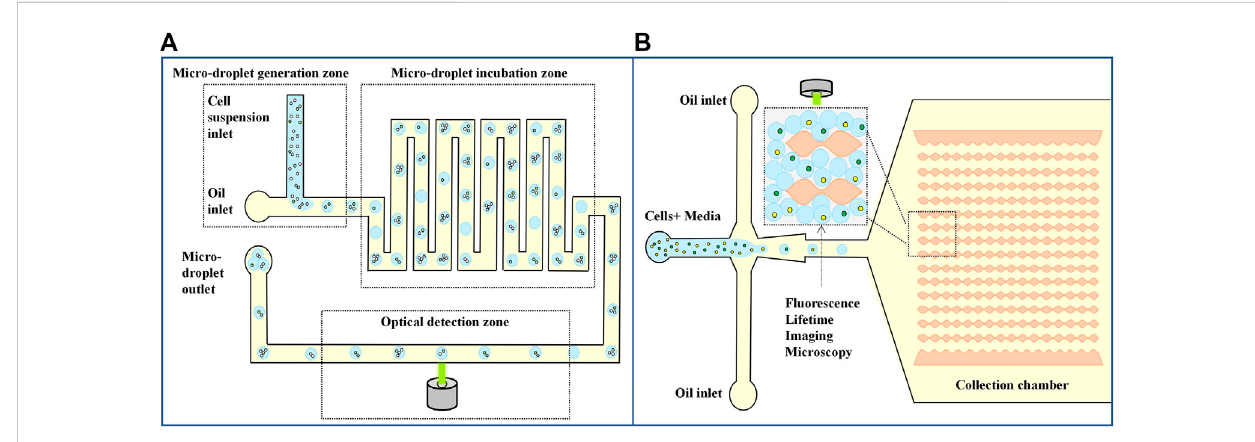
FIGURE 6 Droplet micro fl uidics for Single cell detection. (A) Schematic diagram of a micro fl uid based optical sensing device for labeling free detection of circulating tumor cells (Chiu et al., 2015). (B) Label-free metabolic classi fi cation of single cells in droplets using the phasor approach to fl uorescence lifetime imaging microscopy (Ma et al.,